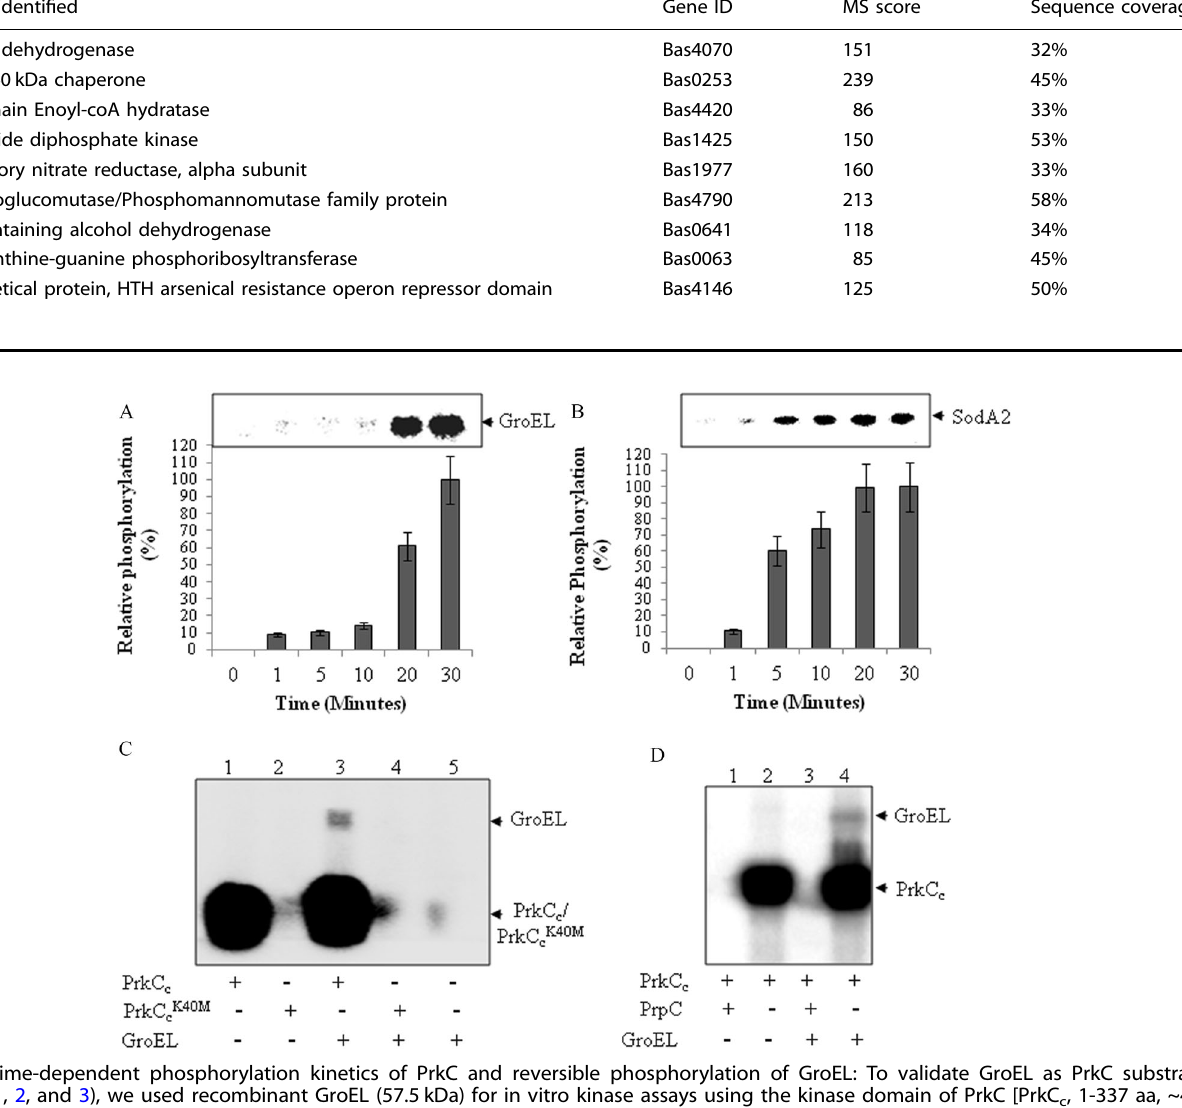
Table 3. Phospho-enriched proteins in Bas -wt identi fi ed by mass spectrometry Protein identi fi